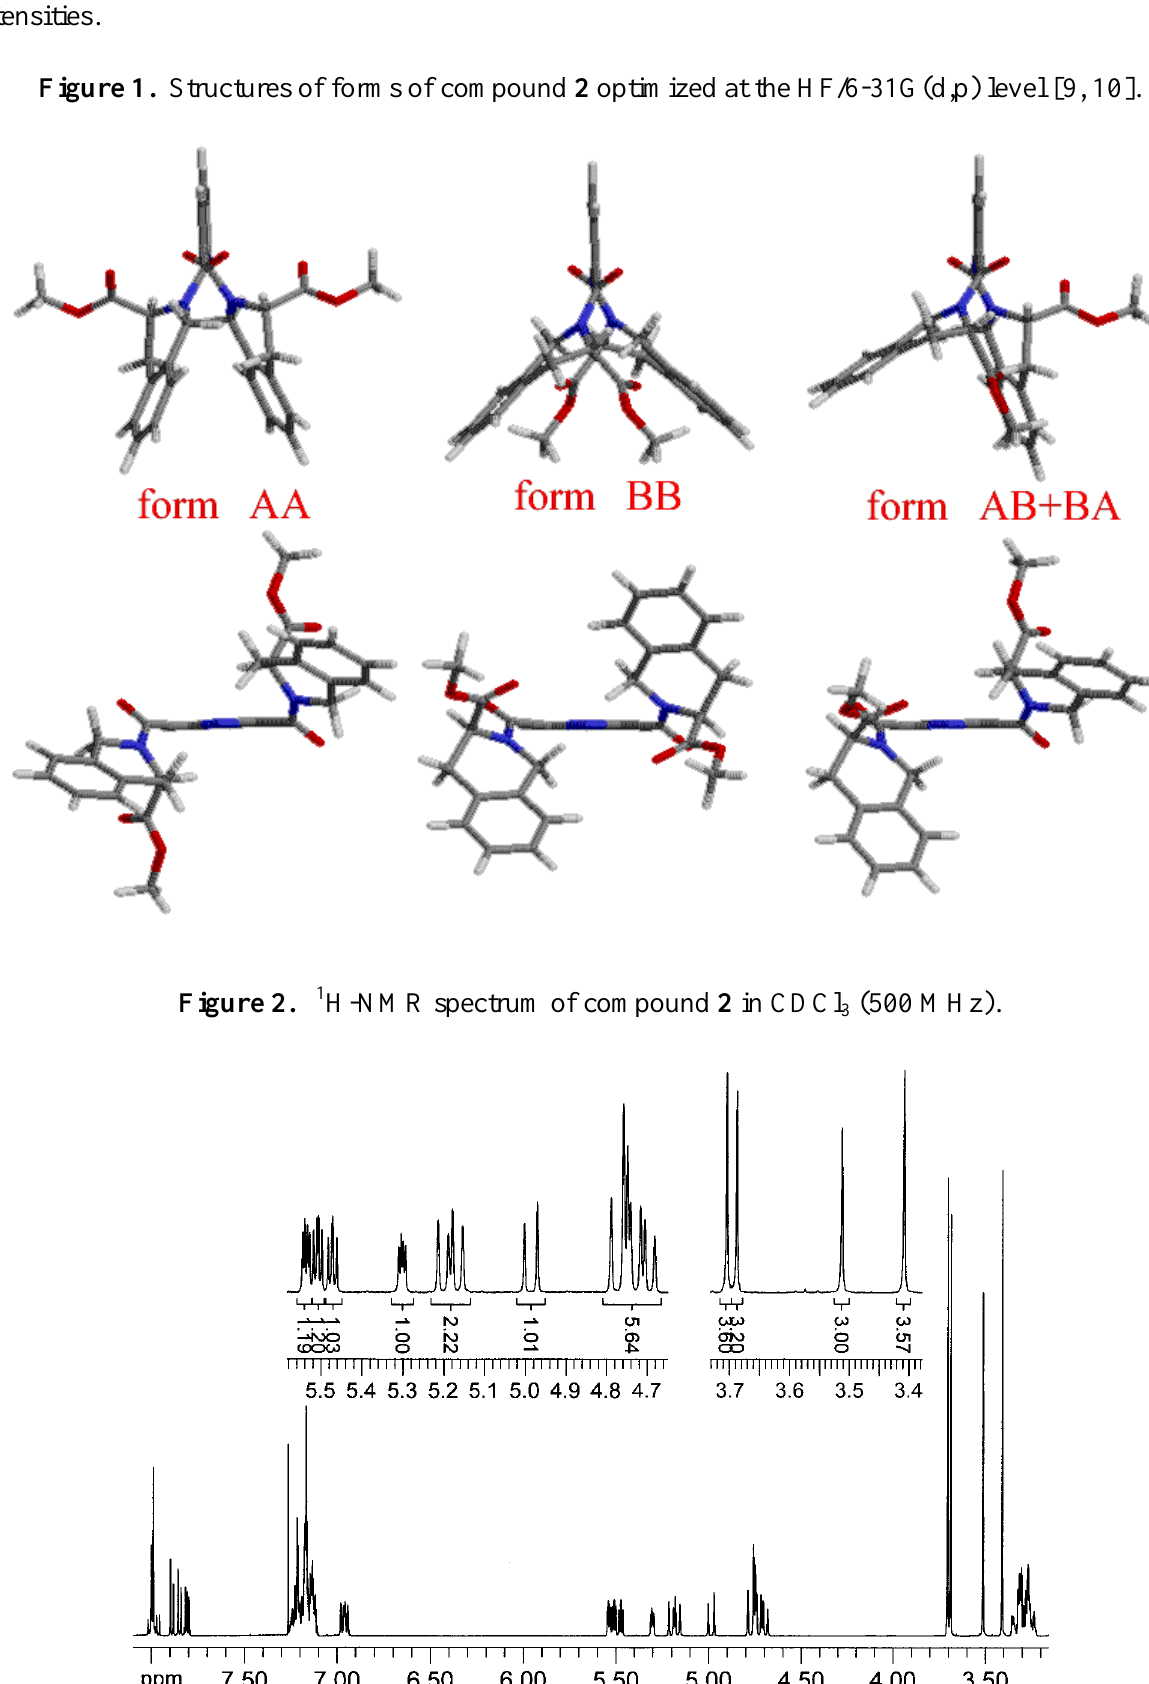
Figure 1. Structures of forms of compound 2 optimized at the HF/6-31G(d,p) level [9, 10].